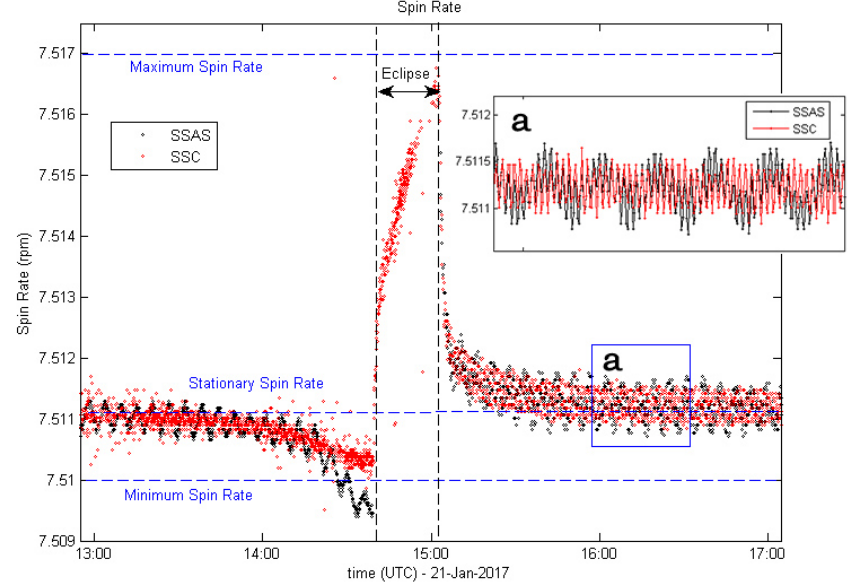
Figure 6. Spacecraft’s SSAS and SSC calculated spin rate on 21 January 2017 from 13:00 to 17:00 UTC. Subfigure a zooms to the shown part.